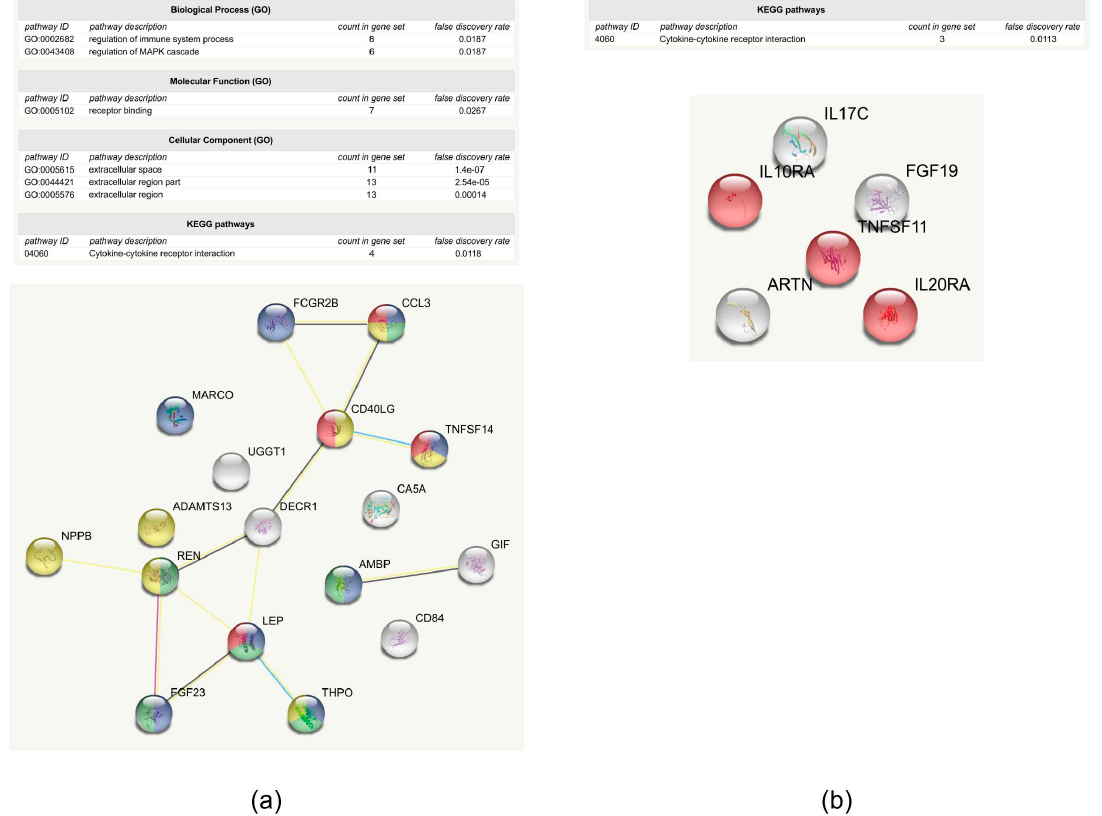
Figure 2. Proteins present with different frequency in the groups. ( a ) Proteins that are less likely to be present in samples belonging to a group with complications; ( b ) proteins that are more likely to be present in samples belonging to a group with complications. In both cases, the upper part of the figure shows the enrichment table generated by String. In the enrichment table, the name and GO code of the enriched pathway, the number of proteins belonging to the pathway, and the false discovery rate are indicated. The lower part of the figures show the network generated by String, with each ball representing a protein, and lines representing protein–protein interactions. Proteins colored with red participate in cytokine–cytokine receptor interaction, the blue color represents the proteins that are responsible for the regulation of immune system processes, and proteins colored with green participate in the regulation of the MAPK cascade, while the ones colored with yellow are responsible for receptor binding. Proteins are represented by their gene name.